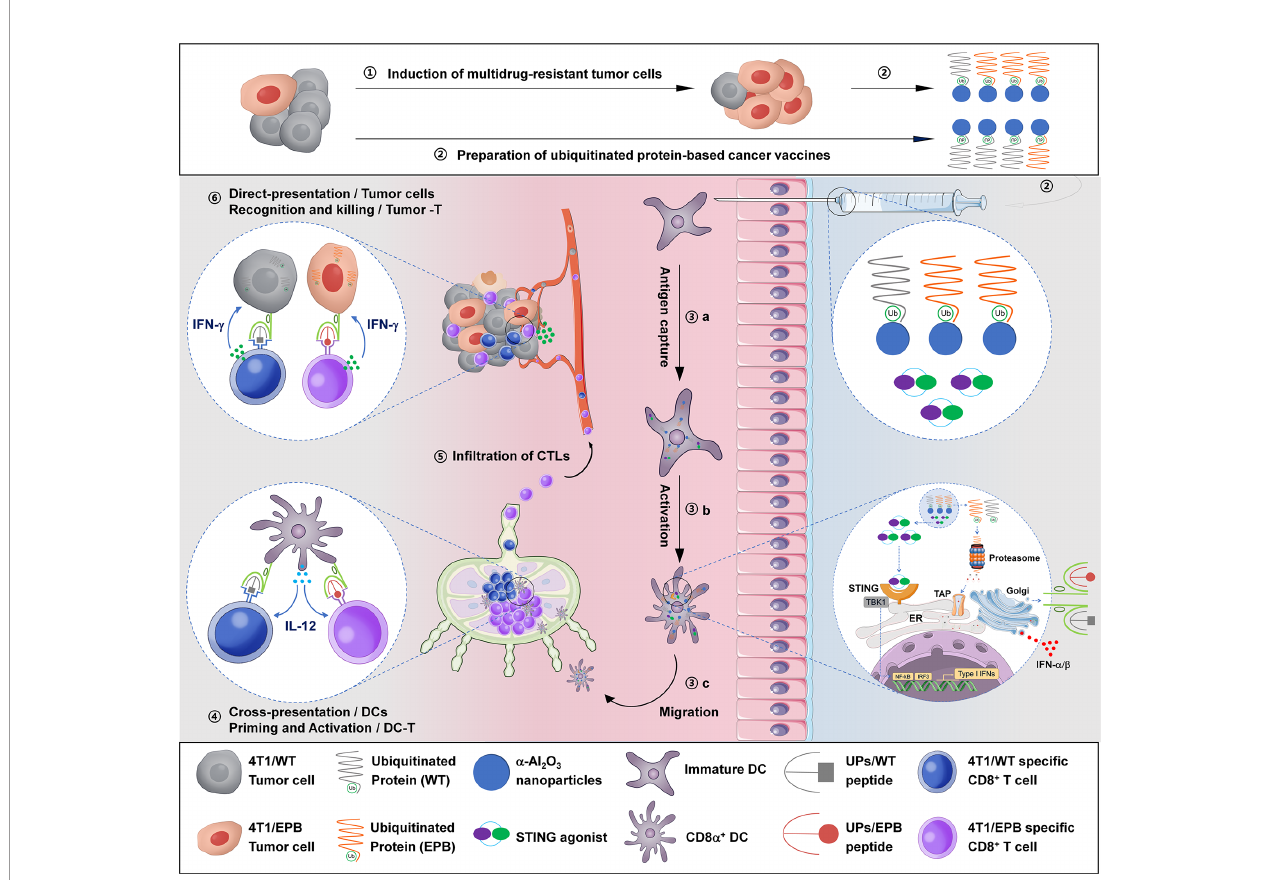
FIGURE 7 | Schematic illustration of the anti-tumor immune responses triggered by ubiquitinated protein-4T1/epirubicin nanovaccine combined with stimulator of interferon gene